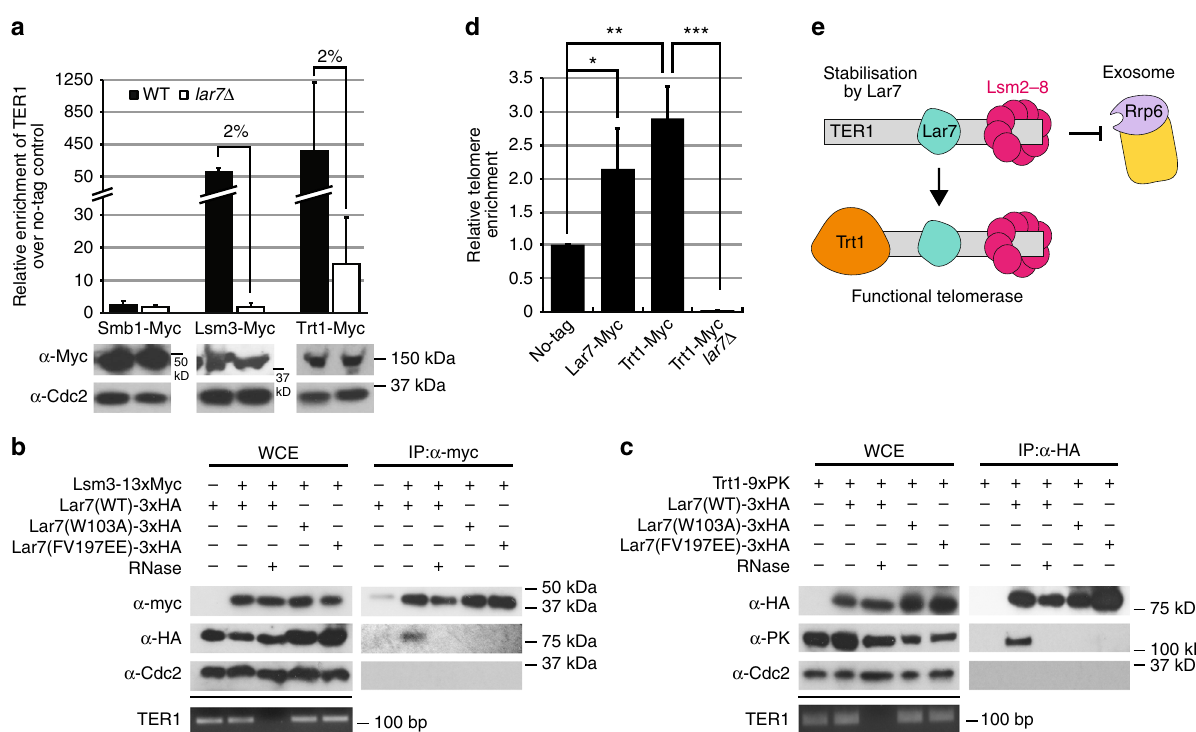
Fig. 5 Lar7 is required for telomerase assembly and is an integral component of the telomerase complex. a Quanti fi cation using RT-qPCR of TER1 mRNA in lysates following immunoprecipitation using α -myc. Values were normalised fi rst to actin and then to an untagged control. Data represented as a mean of two independent experiments. Error bars show standard deviation. Western blot demonstrates successful expression and immunoprecipiation. Cdc2 was used to control for sample input. b Whole-cell extracts (WCEs) were immunoprecipitated using α -myc in the presence or absence of RNase, as indicated. Resulting immunoprecipitates were hybridised with α -myc and α -HA. Cdc2 was used as a control for sample input. c Whole-cell extracts (WCE) were immunoprecipitated using α -HA. d Chromatin immunoprecipitation (ChIP) and qPCR to quantify telomeric DNA in lysates following immunoprecipitation with α -myc. Data is represented as a mean of three independent experiments. Error bars show standard deviation. Lar7-Myc and Trt1-Myc precipitated signi fi cantly more telomeric DNA vs. WT ( p = 0.0327 and p = 0.0024, respectively). This was signi fi cantly abrogated in Trt1-Myc lar7 Δ cells ( p ≤ 0.0001, unpaired t test * at p > 0.05, ** at p < 0.01 and *** at p < 0.001). e Model indicating the role of Lar7 in stabilising the interaction between Lsm2 – 8 and